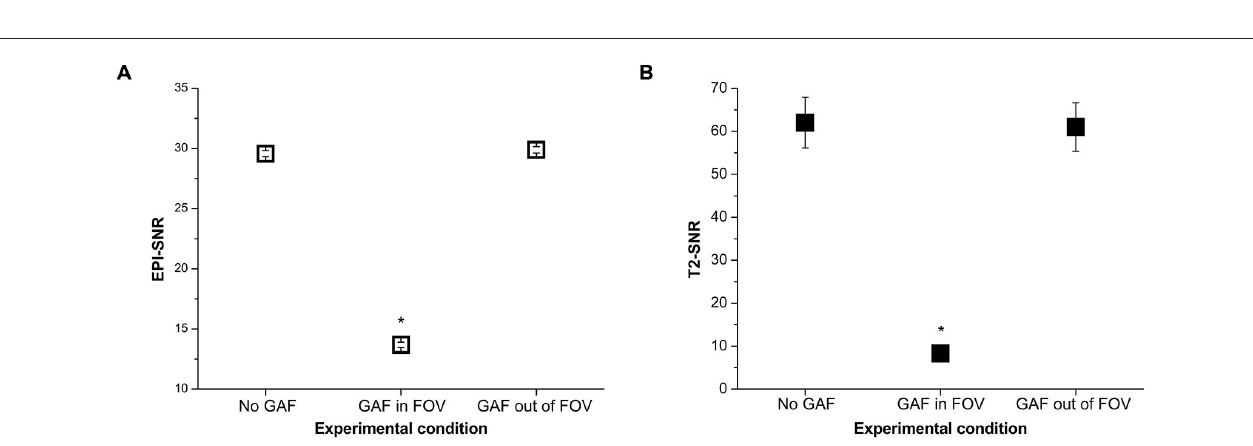
FIGURE 8 | SNR values (mean ± s.e.) calculated on the EPI (A) and T2 (B) images in the different experimental conditions. ∗ Indicates statistical significance (SNR in the GAF in FOV condition was significantly reduced with respect to the other two conditions).